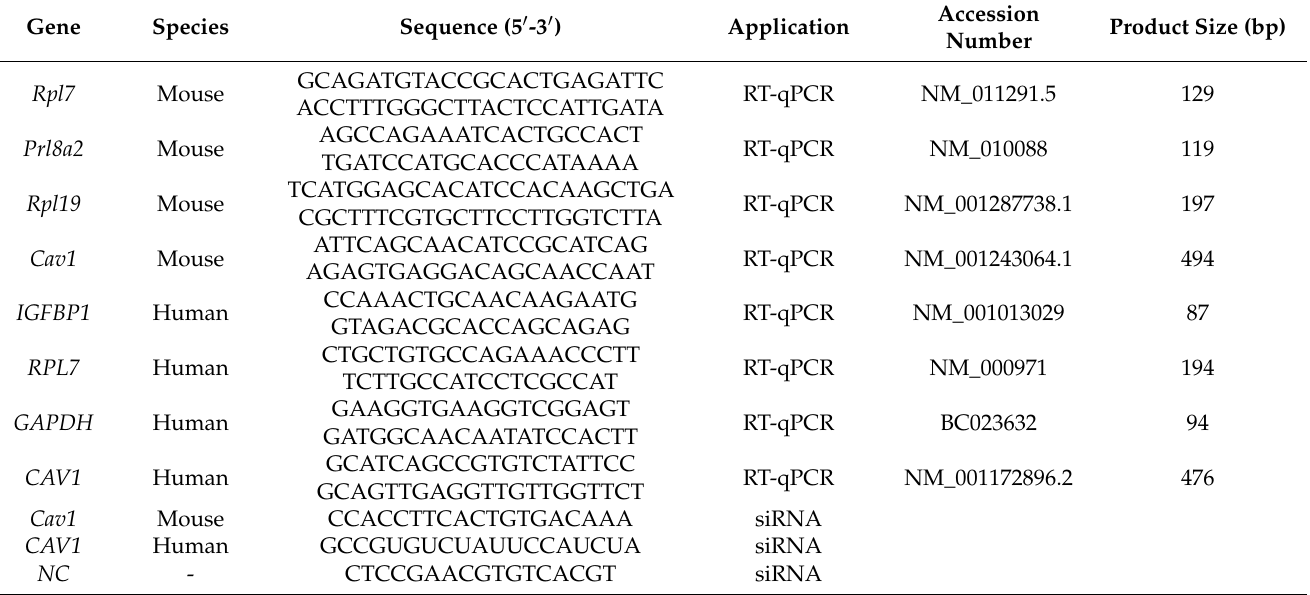
Table 1. Data from Real-Time PCR were analyzed using the 2 − Table 1. Primers and siRNA sequences used in this